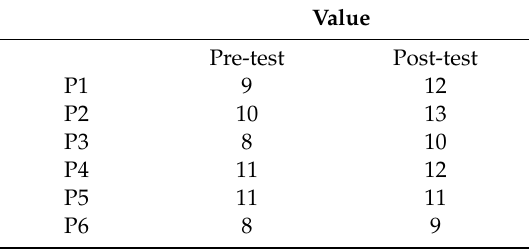
Table 10. Grouped results pre-test / post-test of the self-awareness test: Do they openly show their emotions?